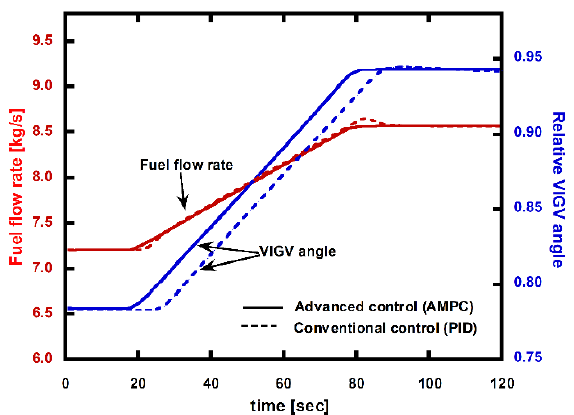
Figure 19. Simulated variations in fuel flow rate and VIGV angle with increasing load (ramp rate: 30 MW/min).